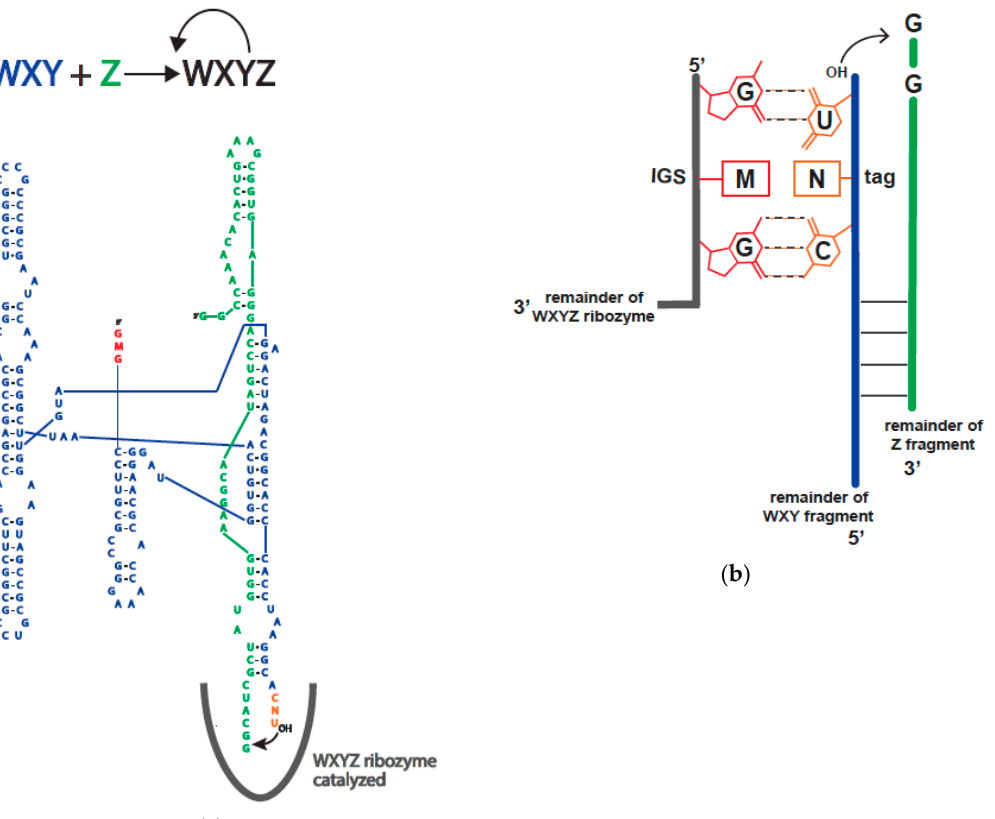
Figure 1. The covalent self-assembly reaction by fragments of the Azoarcus group I intron ribozyme. ( a ) A schematic of the WXY (155 nt) + Z (45 nt) autocatalytic reaction, as first described in ref. [3]. The internal guide sequence (IGS) (red) of a WXYZ ribozyme (either in pieces or covalently contiguous) binds to the tag (orange) of a WXY fragment (blue) and catalyzes a recombination reaction with a Z fragment (green) to produce another WXYZ ribozyme, plus a free guanosine nucleotide. The reaction is autocatalytic; ( b ) A blowup of the IGS-tag interaction, where the middle nucleotides of the IGS (i.e., M) and of the tag (i.e., N) can be freely varied to all 16 possible combinations [5]. During natural cellular self-splicing of the Azoarcus tRNA Ile intron, the triplet IGS and tag